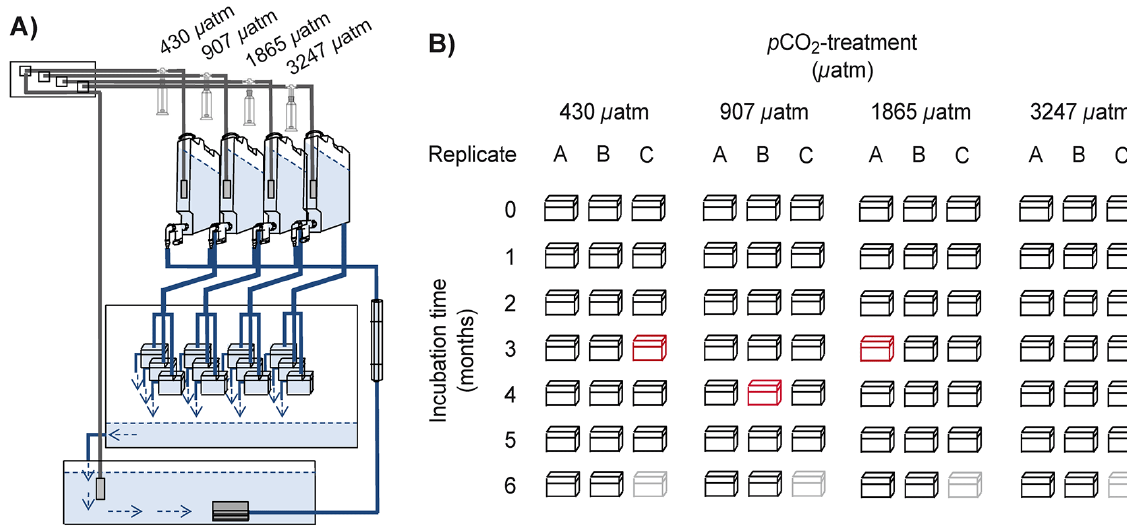
Fig. 1. (A) Scheme: experimental setup of A. aomoriensis in a closed flow-through system. Water equilibrated with four p CO 2 levels (430, 907, 1865 and 3247µatm) supplied from the compact jerrycans into the three replicated culture vessels and drained into a catchment tank, from where is was pumped up again to the jerrycans. (B) Experimental design: altogether 84 culture vessels, replication for four p CO 2 treatments (430, 907, 1865 and 3247µatm) during 6 months of incubation time. Red culture vessels: disappeared during incubation time. Culture vessels marked in light grey refer to treatments where carbonate chemistry parameters were measured in the supernatant seawater and sediment pore water in one of the three replicates after 6 months of incubation